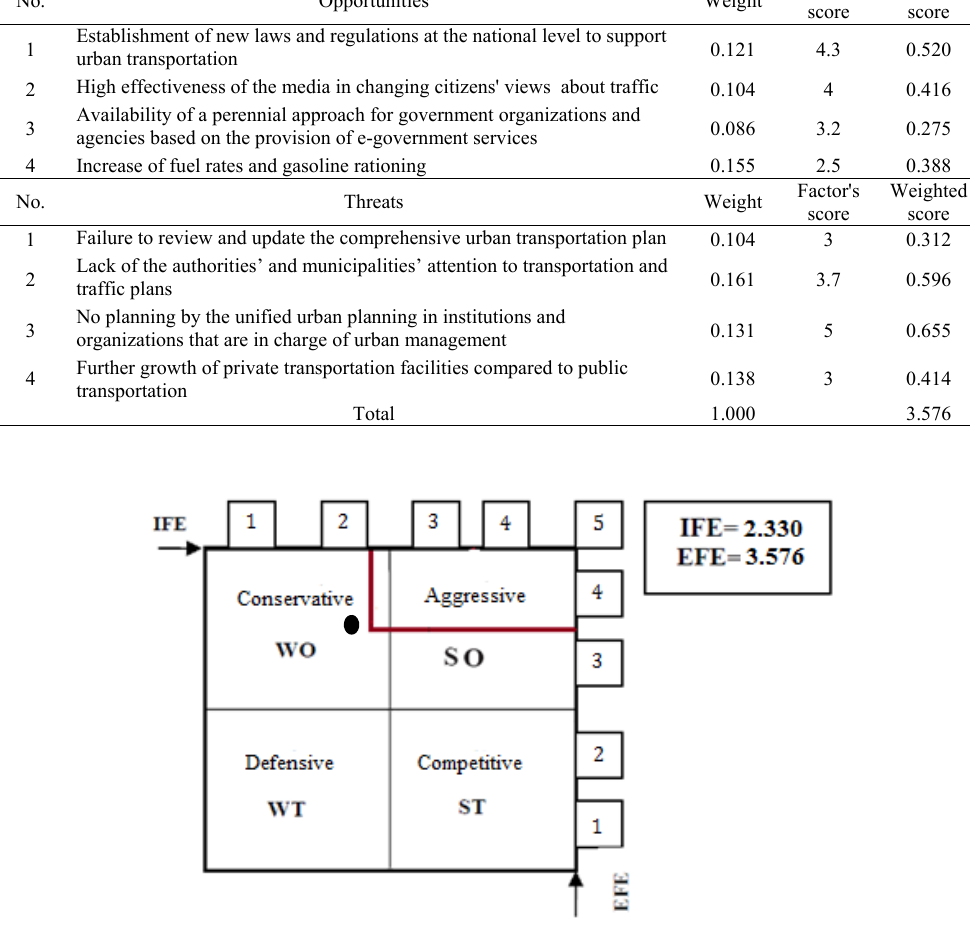
Fig. 3: Internal and external factors matrix